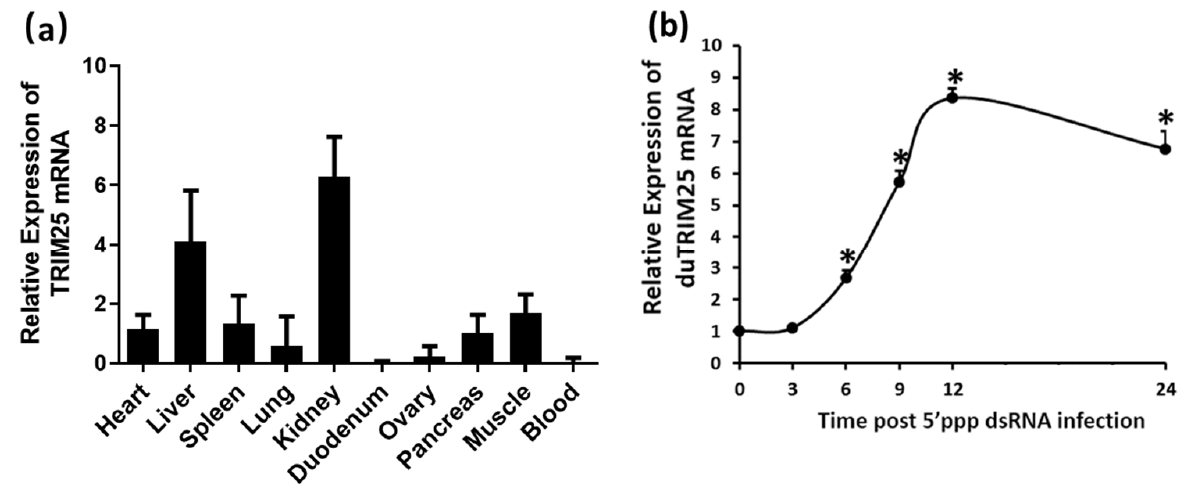
Figure 3. ( a ) Relative expression levels of duTRIM25 in various tissues of five three-day-old healthy Shaoxing egg-laying ducks. The tissues tested included heart, liver, spleen, lung, kidney, duodenum, ovary, pancreas, muscle and blood. The mRNA expression levels were normalized to the expression of duck β -actin gene. Each bar represents the mean ± SE ( n = 5). ( b ) Relative expression levels of duTRIM25 in DEFs, treated with 5 ′ ppp dsRNA and collected after 0, 3, 6, 9, 12 and 24 h. Each point represents the mean ± SE ( n = 3). Asterisks indicate significant differences determined by a t -test between treatments 6, 9, 12 and 24 h and treatment 0 h (* p < 0.05).